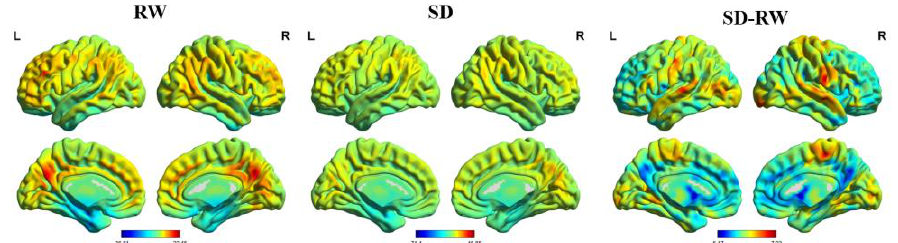
Figure 3. Regional homogeneity map. Compare to RW, right Postcentral regional homogeneity significant increased following SD. RW, rested wakefulness; SD, sleep deprivation.